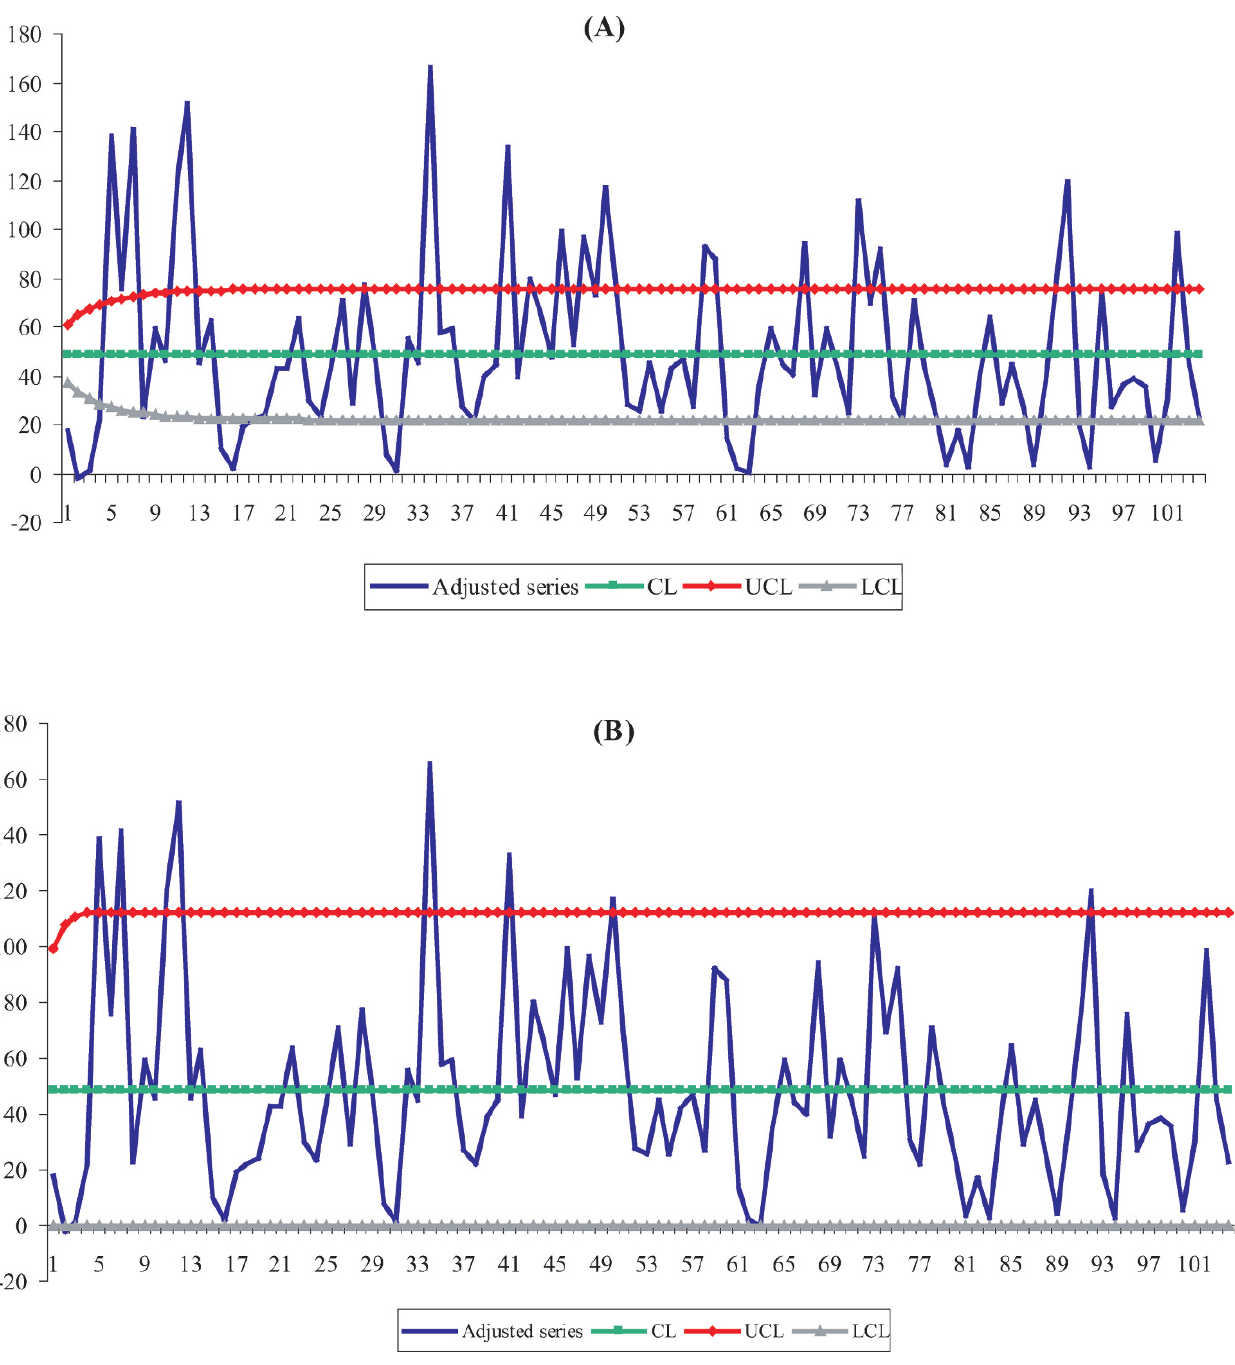
Figure 5 - (A) An EWMA control chart with parameters L=2.814 and l =0.10 and (B) an EWMA control chart with parameters L=3.054 and l =0.40. Table 4 - Weeks with atypical points in the years 2004 and 2005 according to the utilized methods. Chart